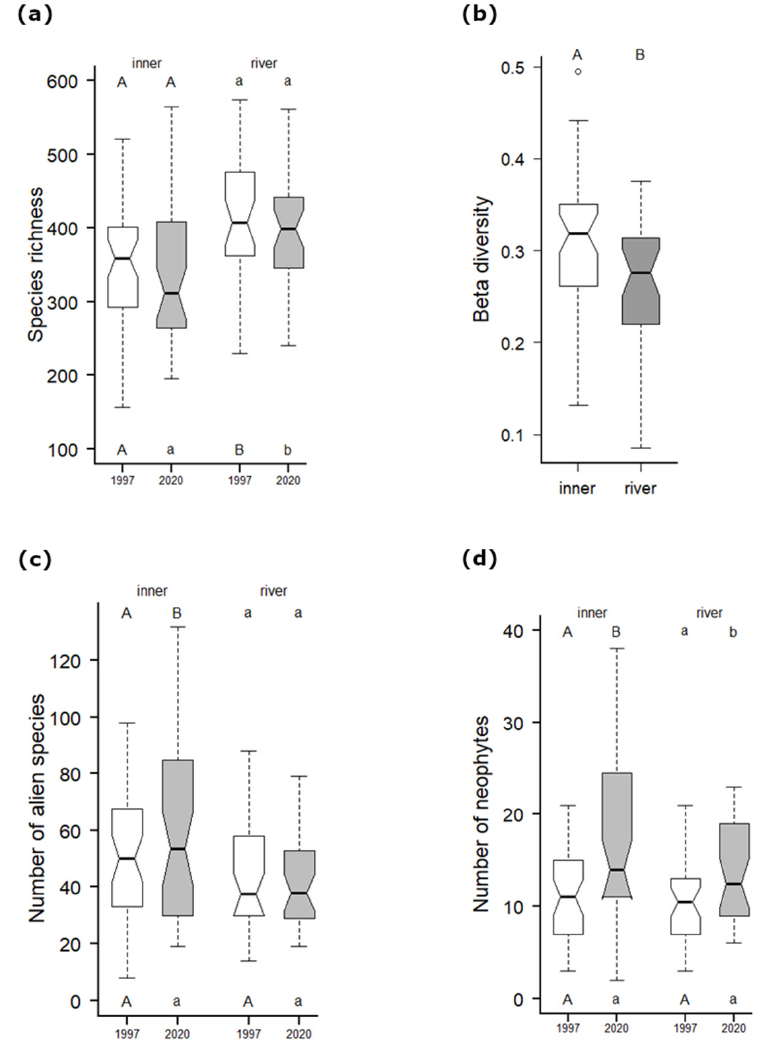
Figure 4. Changes and differences in ( a ) species richness, ( b ) beta diversity (Sörensen dissimilarity; non-pair t -test), ( c ) number of alien species and ( d ) number of neophytes per grid cell within both the first (1997) and the second survey (2021) separated into inner (n = 44) and river (n = 34) group cells (see Methods). The letters above boxes indicate the results of pairwise t -tests between surveys within each group, while the letters below boxes show results of the non-pair t -test between the groups ( a , c , d ). Whiskers indicate the non-outlier range with the median as the middle; boxes show the 25–75% percentiles.